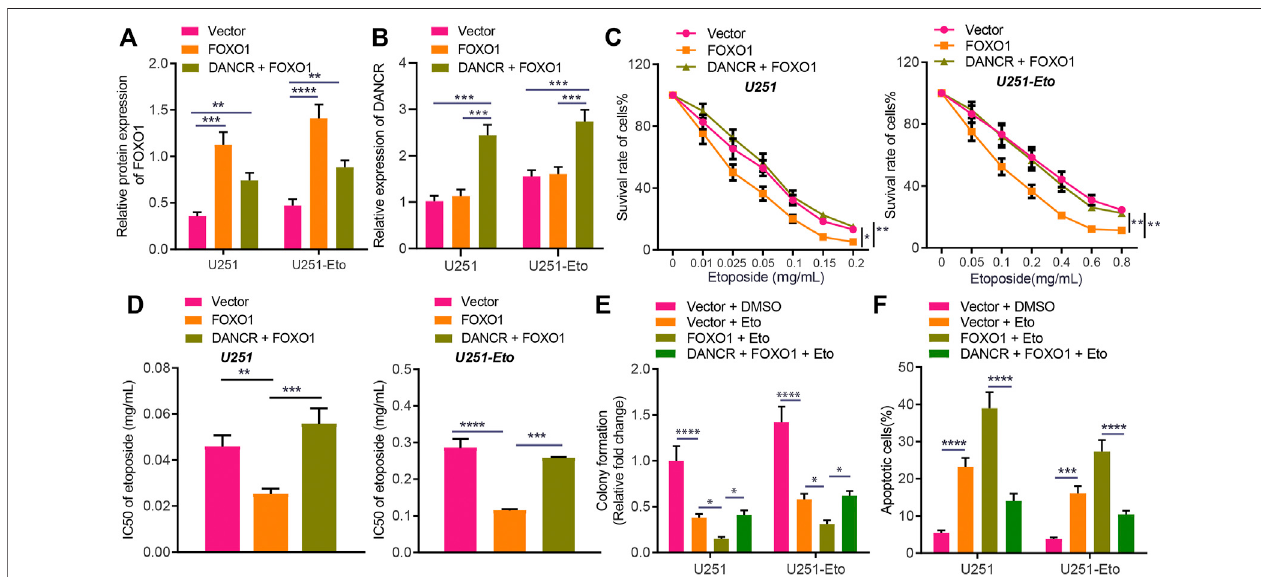
FIGURE 5 | DANCR enhances etoposide resistance of GBM cells by inhibiting FOXO1 expression. (A) Western blot analysis of FOXO1 protein in U251 and U251- Eto cells treated with FOXO1, DANCR, FOXO1 + DANCR, or vector. (B) RT-qPCR analysis of DANCR mRNA expression in U251 and U251-Eto cells treated with FOXO1, DANCR, FOXO1 + DANCR, or vector. (C) MTT analysis ofU251 and U251-Eto cell viability upon treatment with FOXO1, DANCR, FOXO1 + DANCR, or vector. (D) IC 50 of etoposide in U251 and U251-Eto cells upon treatment with FOXO1, DANCR, FOXO1 + DANCR, or vector. (E) Quanti fi cation of colony formation assay onU251andU251-EtocellsupontreatmentwithFOXO1,DANCR,FOXO1+DANCR,orvector. (F) FlowcytometricanalysisofU251andU251-Etocellapoptosisupon treatmentwithFOXO1,DANCR,FOXO1+DANCR,orvector.* p < 0.05,** p < 0.01,*** p < 0.001,**** p < 0.0001.Valuesshownrepresentmean ± standarddeviationof three independently performed experiments. Multigroup data comparison was conducted by one-way ANOVA followed by Tukey post hoc test. Data among groups at different concentrations were compared by two-way ANOVA, followed by Tukey post hoc